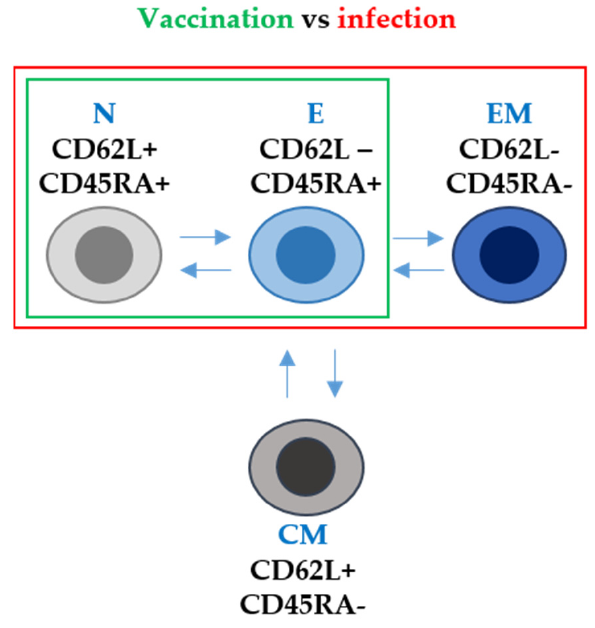
Figure 2. T-cell phenotype after mRNA vaccination and after SARS-CoV-2 infection in terms of CD62L and CD45RA surface marker expression. N, E, EM and CM stand for naïve, effector, effector memory and central memory T-cell subsets. Arrows indicate the differentiation pathways between the different T-cell phenotypes. Within the green box, T-cell subsets differentiated following mRNA vaccination only. Within the red box, T-cell subsets differentiated following infection with SARS- CoV-2.